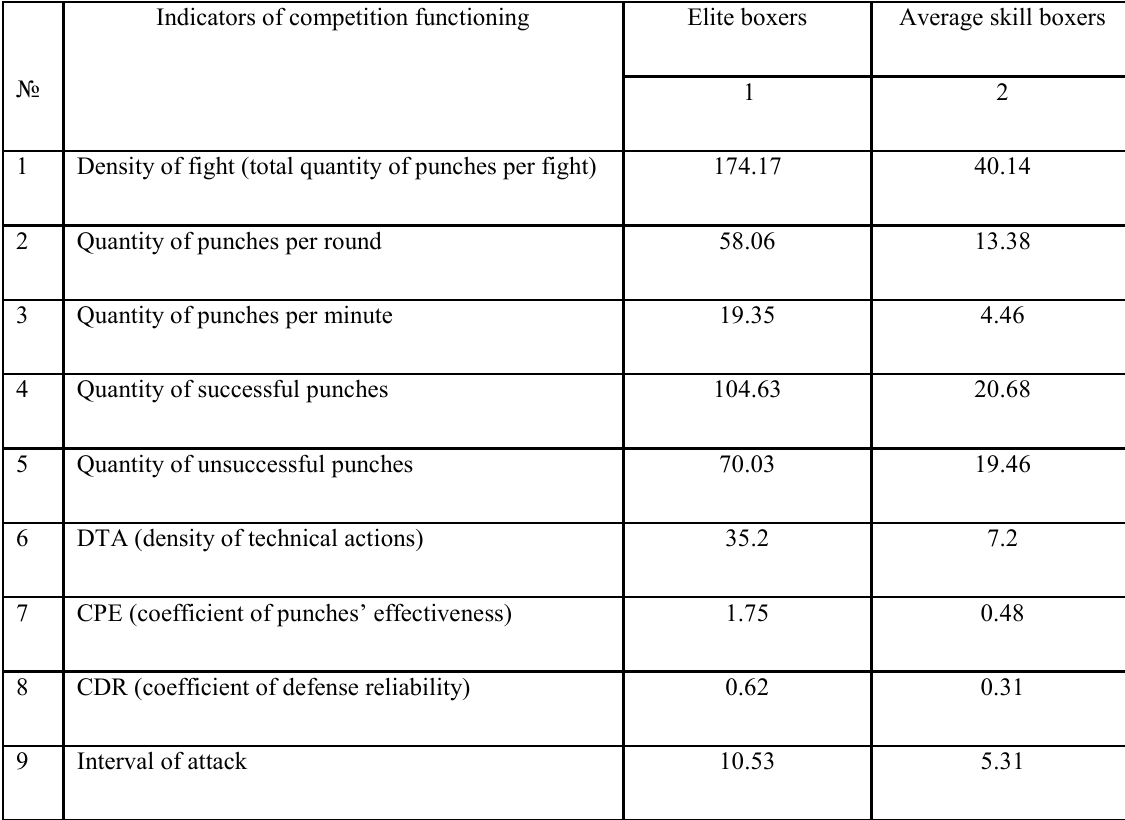
Indicators of average skill and elite boxers’ competition